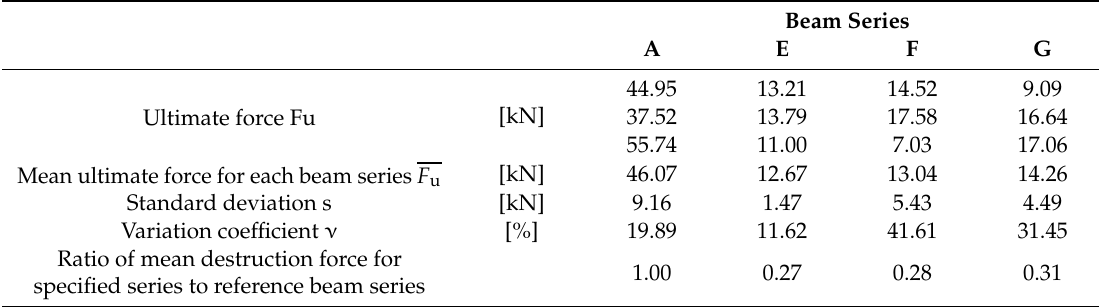
Table 1. Ultimate forces for beams in each series.